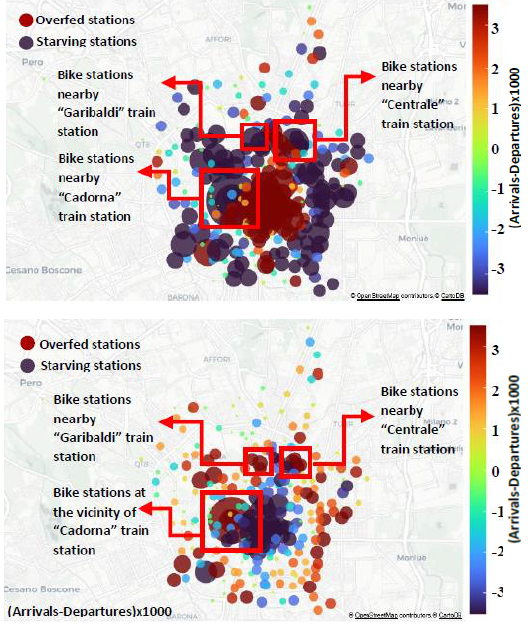
Figure 9. Mobility flows during weekdays, regular users at 08:00 (top) and at 18:00 (bottom)